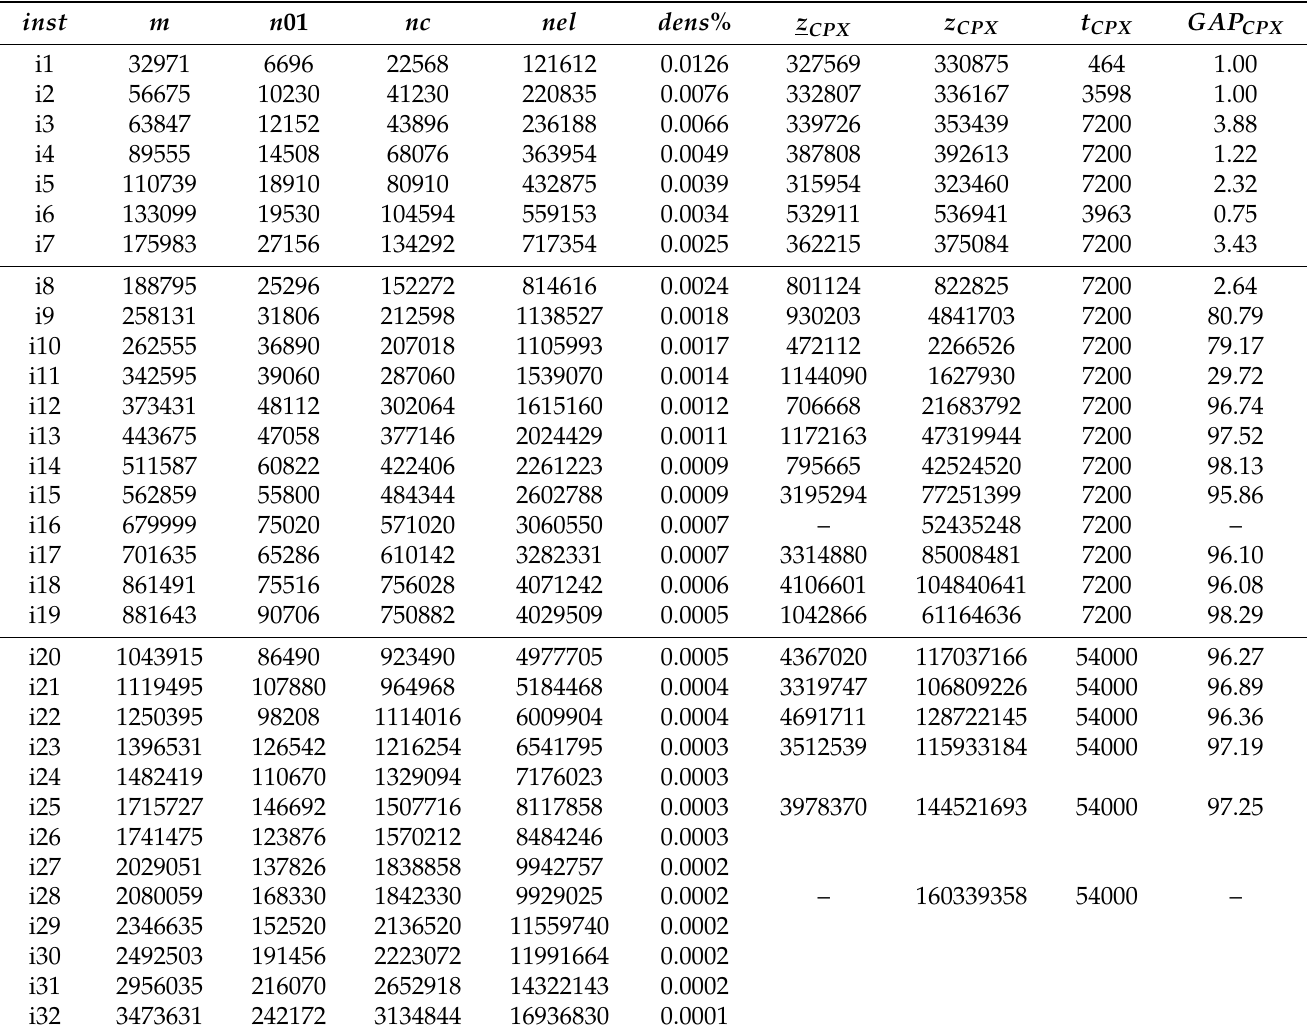
Table 2. S-Hub-NEP model (1)–(30). Dimensions and CPLEX